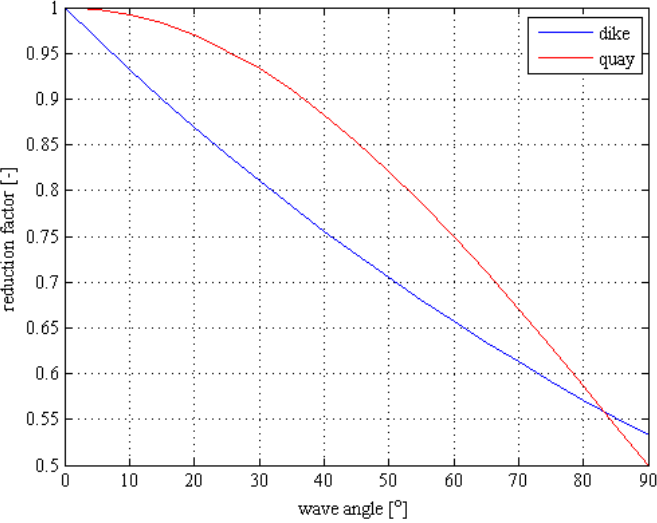
Figure 17. Variation of the reduction factor as function of wave angle. J. Mar. Sci. Eng. 2020 , 8 , x FOR PEER REVIEW